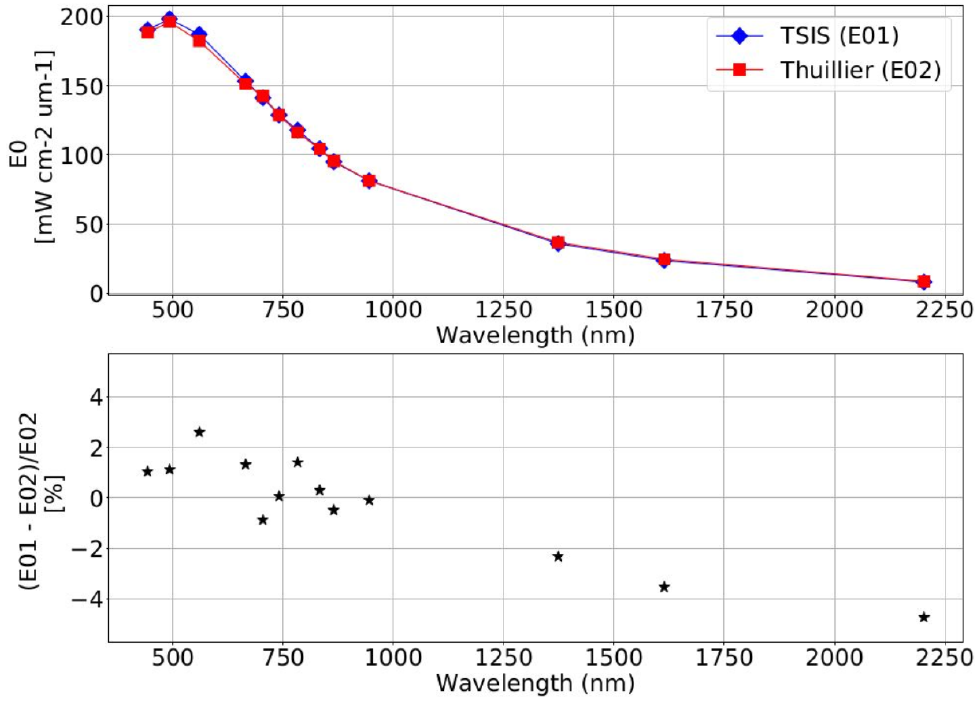
Figure 4. Top : Solar irradiance spectra for Sentinel-2A bands using Thuillier 2003 (red line) and TSIS (blue line) solar models. Bottom : Relative difference (black stars) between the convolved solar